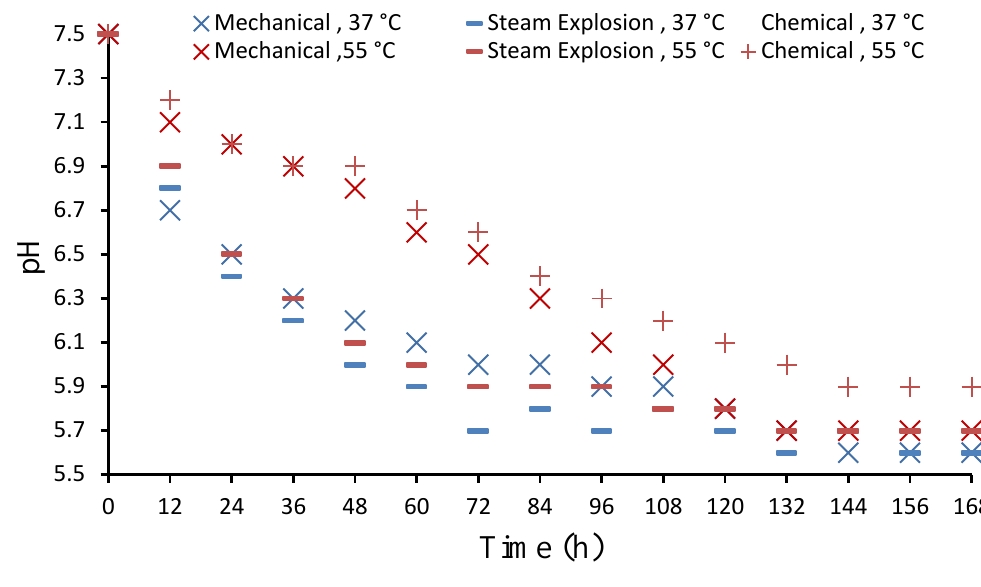
Figure 4. Drop in pH during incubation.